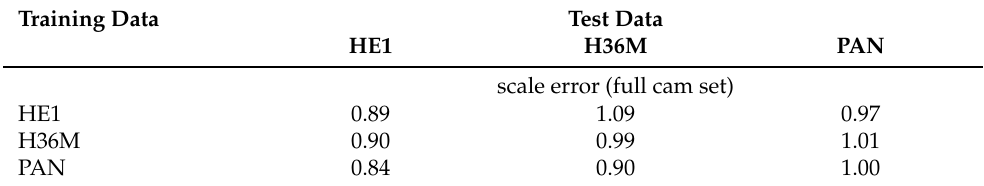
Table 10. Mean scale ratios between ground truth and prediction without scale